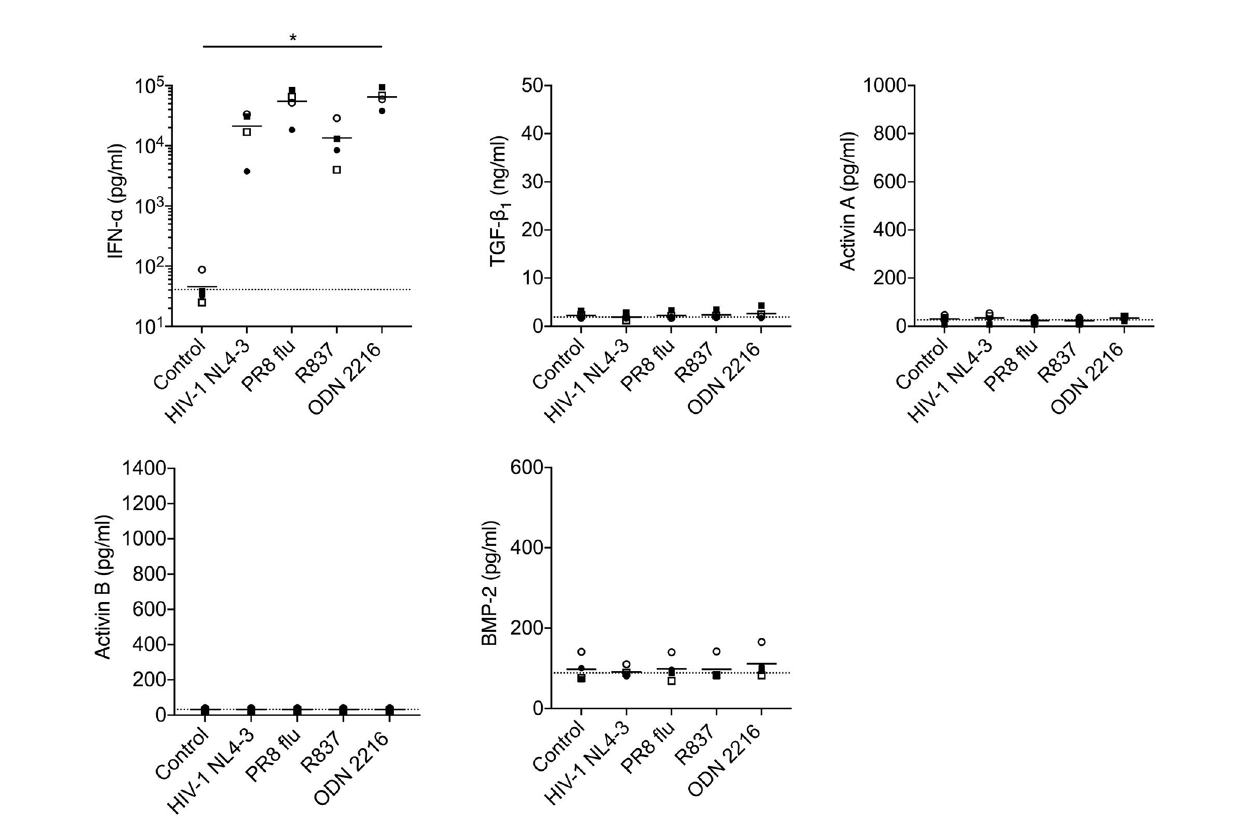
FIGURE 5 | Analysis of production of TGF- b superfamily cytokines by pDCs following in vitro stimulation with HIV-1 or TLR ligands. pDCs isolated from n=4 HIV-1- seronegative donors were cultured with medium only, HIV-1 NL4-3, PR8 in fl uenza virus, the TLR7 agonist R837, or the TLR9 agonist ODN 2216. Concentrations of IFN- a and TGF- b superfamily cytokines in supernatants were measured after 24 h. Symbols indicate datapoints from individual donors; horizontal solid lines represent group means. The horizontal dashed line shows background analyte levels in serum-containing medium (mean of values measured in two independent experiments). Data were analyzed using a one-way ANOVA with Dunnett ’ s post-test comparing to the unstimulated pDC control (*P <